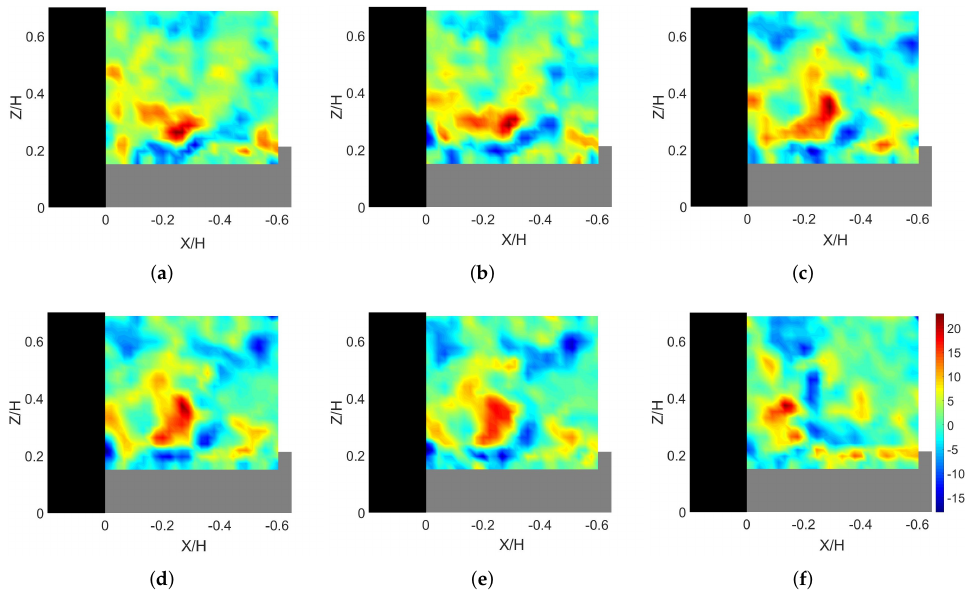
Figure 17. ( a – f ) Instantaneous spanwise vorticity fields showing the transition over − time from backflow mode to zeroflow mode within a representative plane, that is vertical and is in the streamflow = − 0.28. The time interval between consecutive images is 0.02 direction, located at Y H